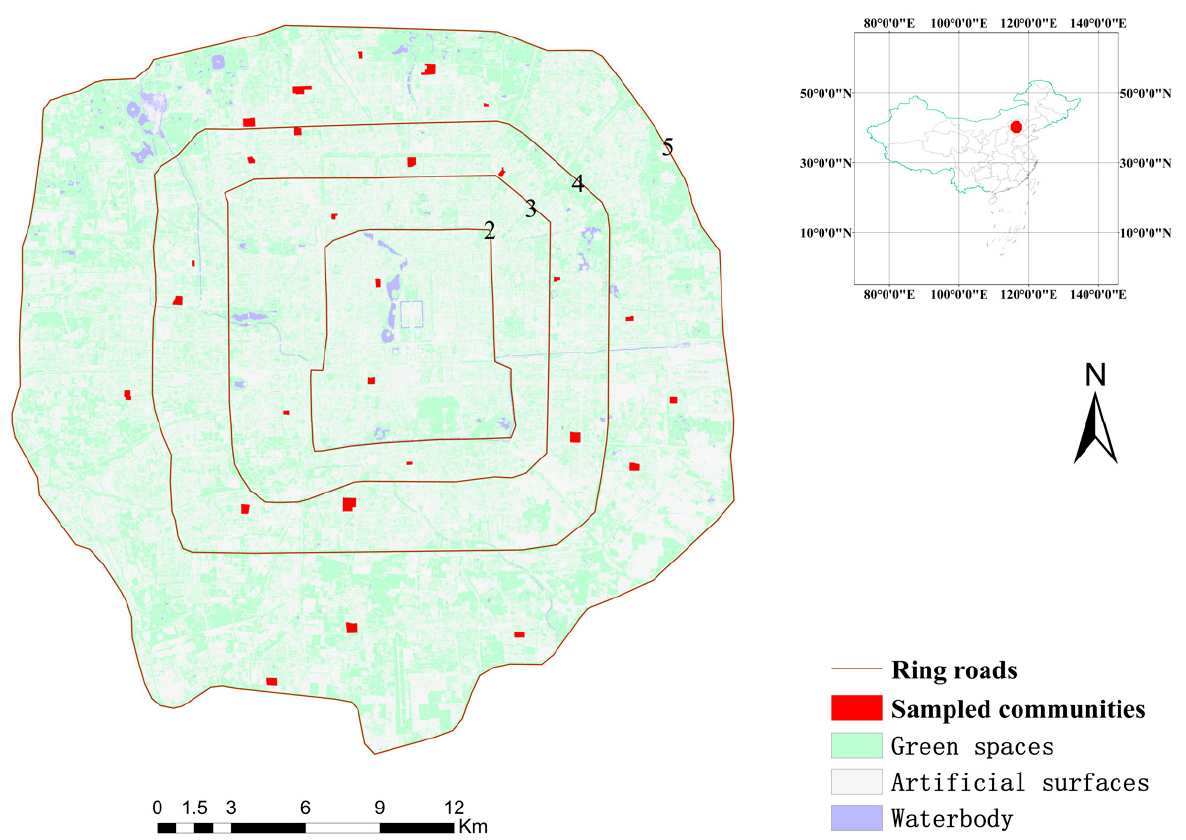
Figure 1. Spatial distribution of our sample sites within urban Beijing. The brown concentric lines indicate urban Beijing’s major beltways (2nd–5th). All the samples are spaced more than a kilometer apart.